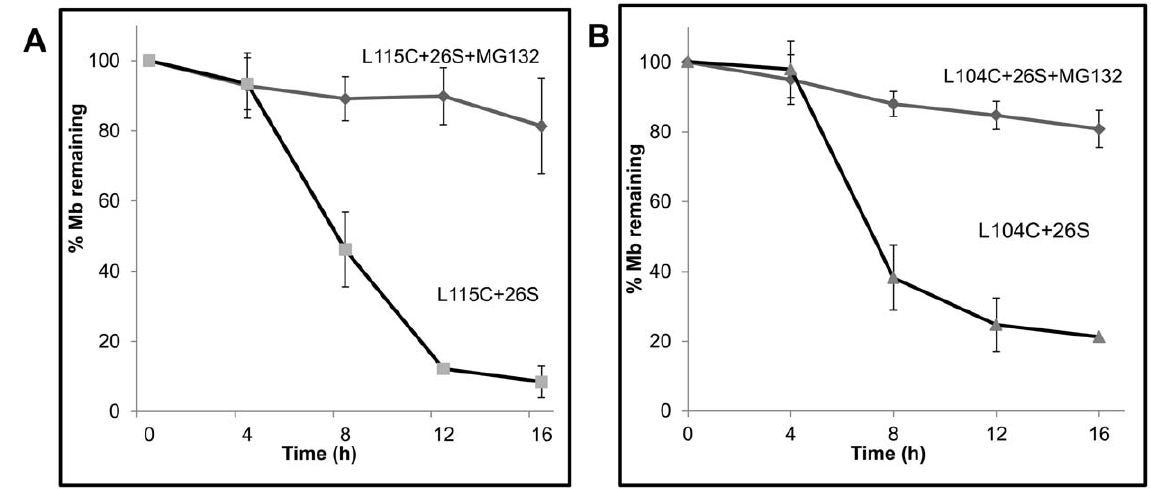
Figure 6. Mutation of buried Leu residues in the G-helix shortens the half-life of apoMb. (A) Apo L115C and (B) apo L104C mutant proteins were incubated with proteasome in the presence or absence of MG132. Rate of degradation was followed by SDS-PAGE and quantified as described in methods. Data represent mean values of at least three independent experiments 6 S.D.